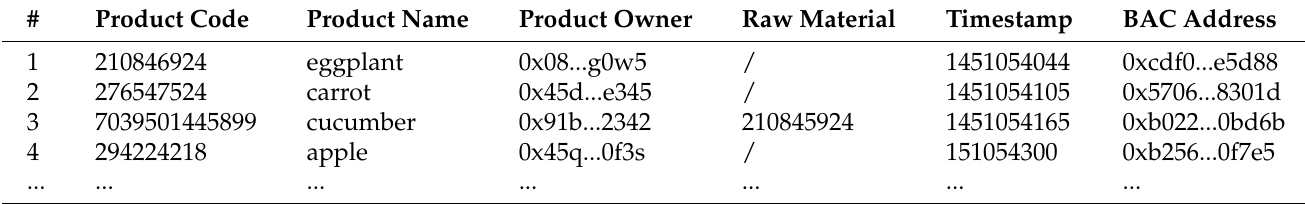
Table 4. Example of Product Registration Contract (PRC) contract product information.